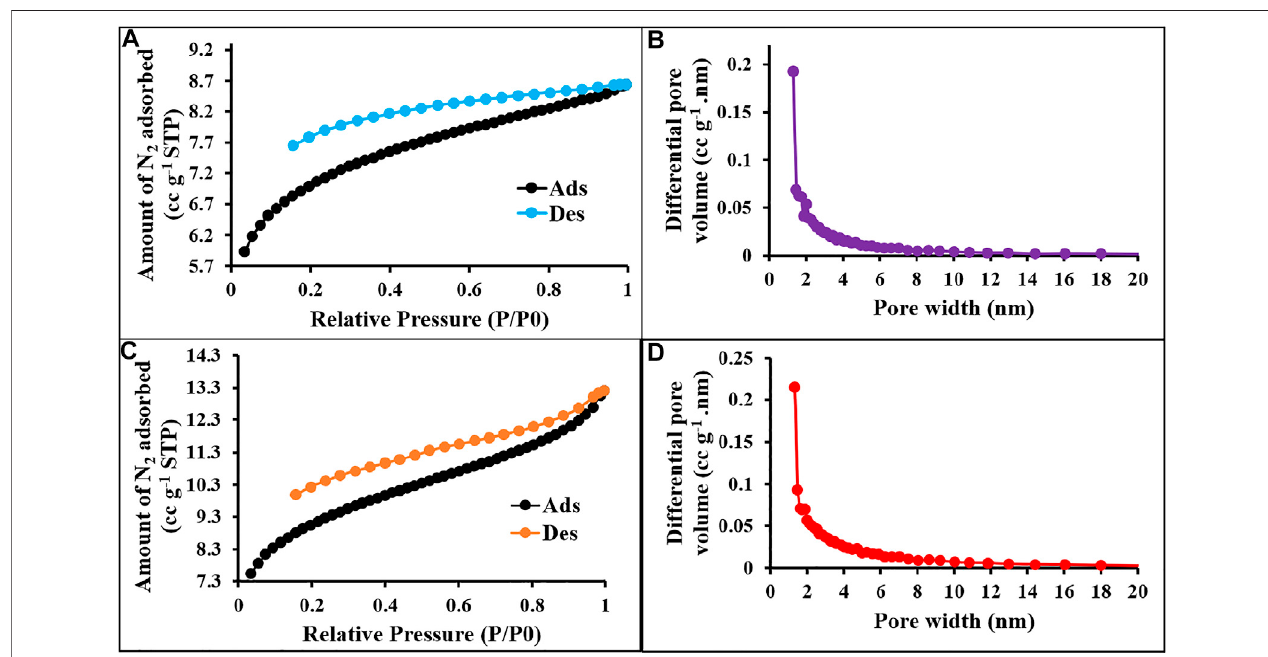
FIGURE 2 | N 2 sorption – desorption isotherms and pore size distribution curves of p-2CzPN (A,B) and p-4CzPN (C,D) at 77 K.